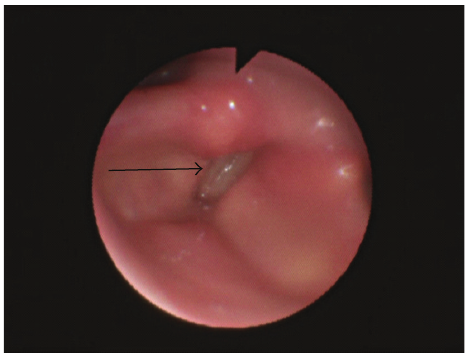
Figure 2: Vocal cords paralysis reported in